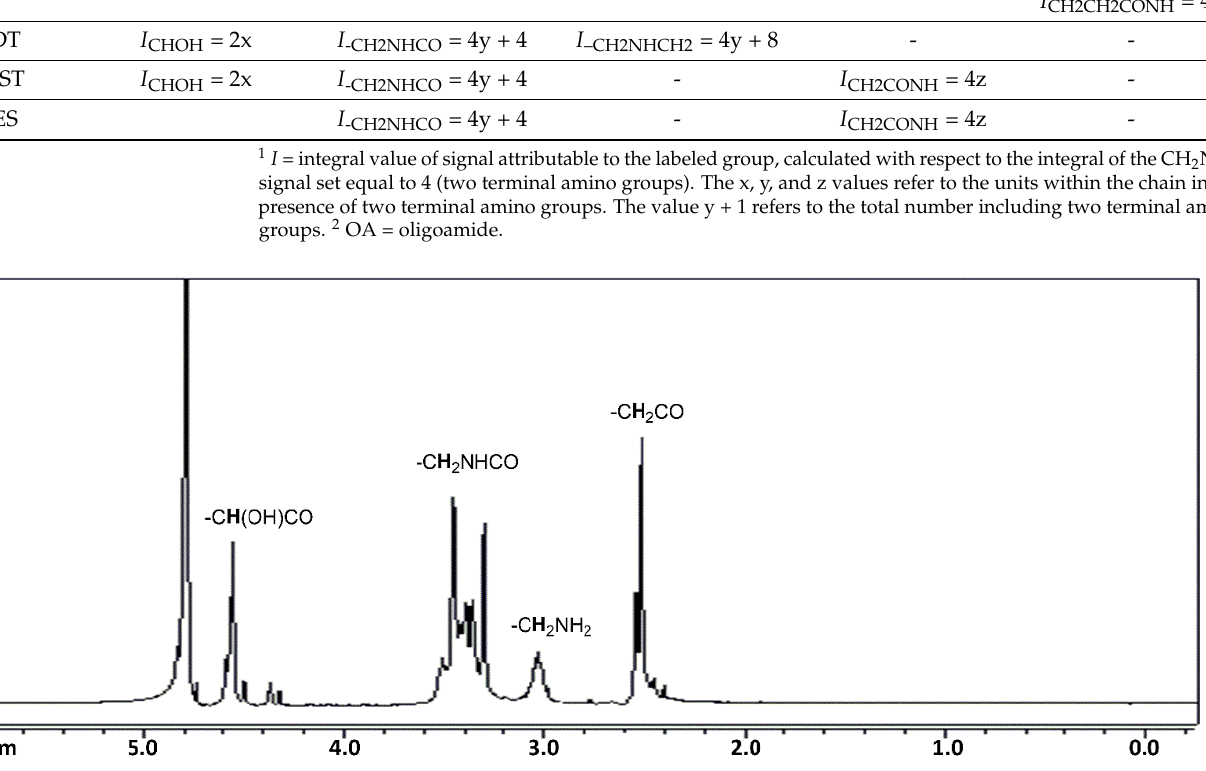
Figure 3. 1 H NMR spectrum in D 2 O of oligoamide EST.